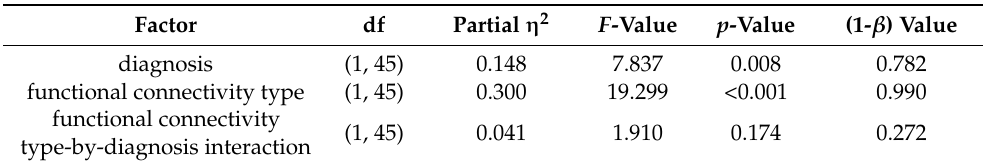
Table 3. Main effect of diagnosis, main effect of RSFC type, and type–diagnosis interaction revealed by two ‐ way ANOVA for Hb ‐ RSFC.